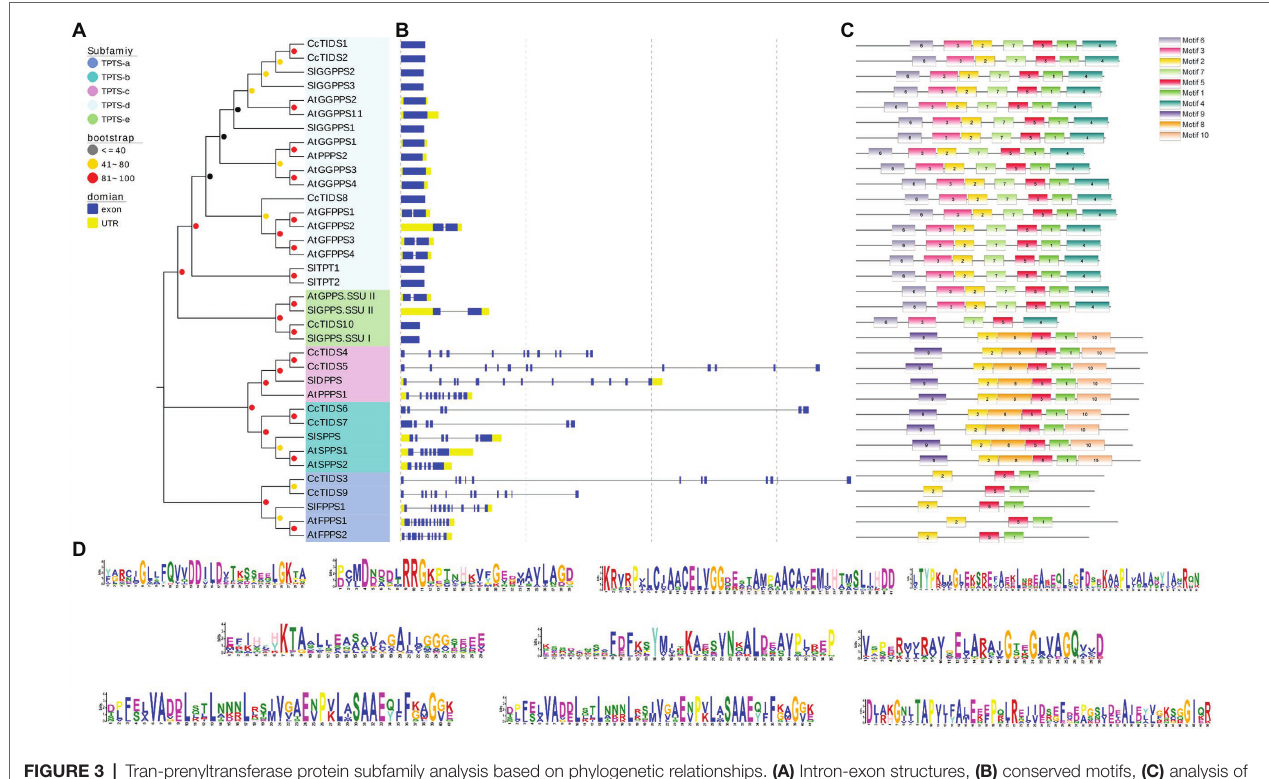
FIGURE 3 | Tran-prenyltransferase protein subfamily analysis based on phylogenetic relationships. (A) Intron-exon structures, (B) conserved motifs, (C) analysis of C. camphora (Cc)TIDS, Arabidopsis thaliana (At)TIDS, and Solanum lycopersicum (Sl)TIDS. (D) Legend depicting the protein sequence of the corresponding motif.